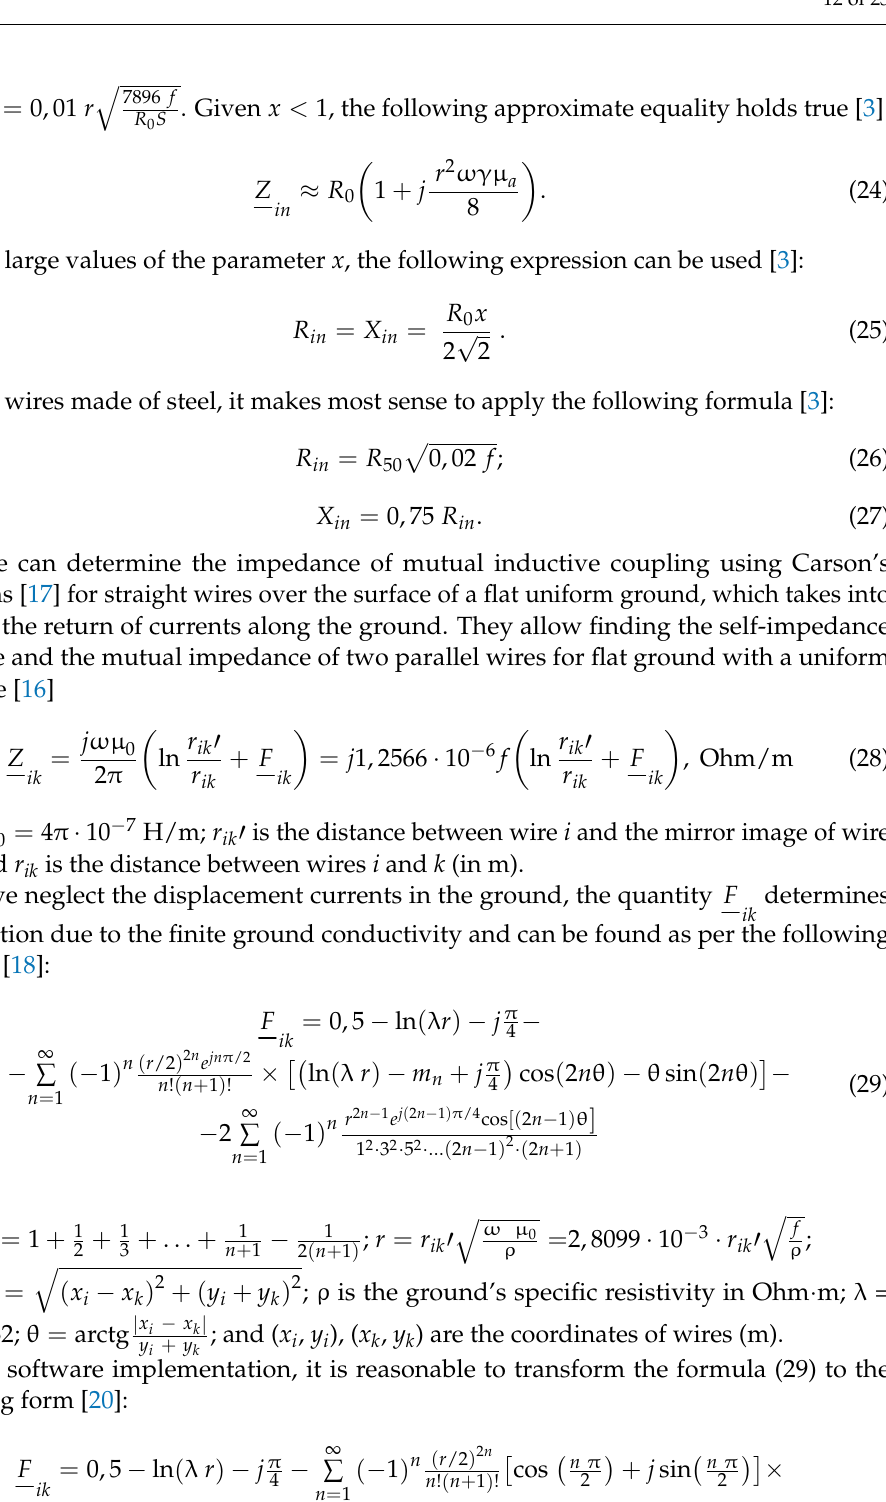
30 C Figure 5. Original circuit of the power transmission line.